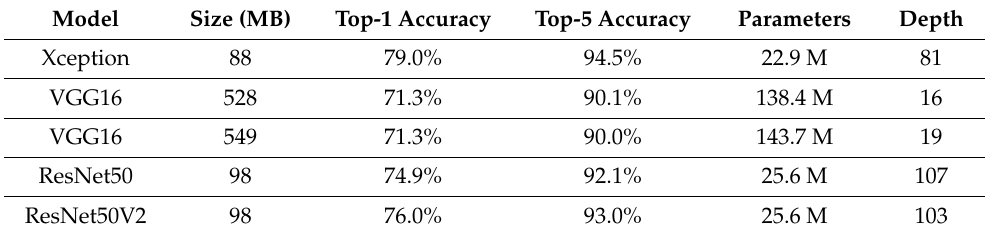
Table 1. Comparison of transfer learning models.